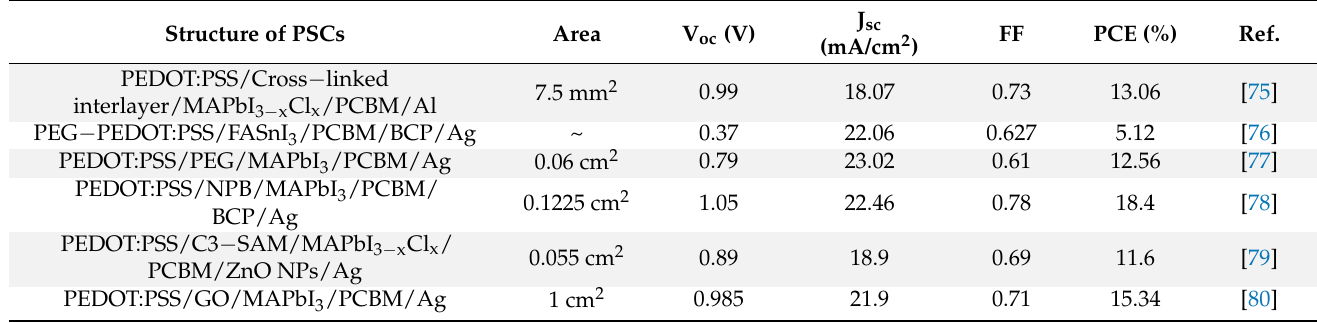
Table 4. Performances of several representative inverted PSCs on the basis of interfacial modified